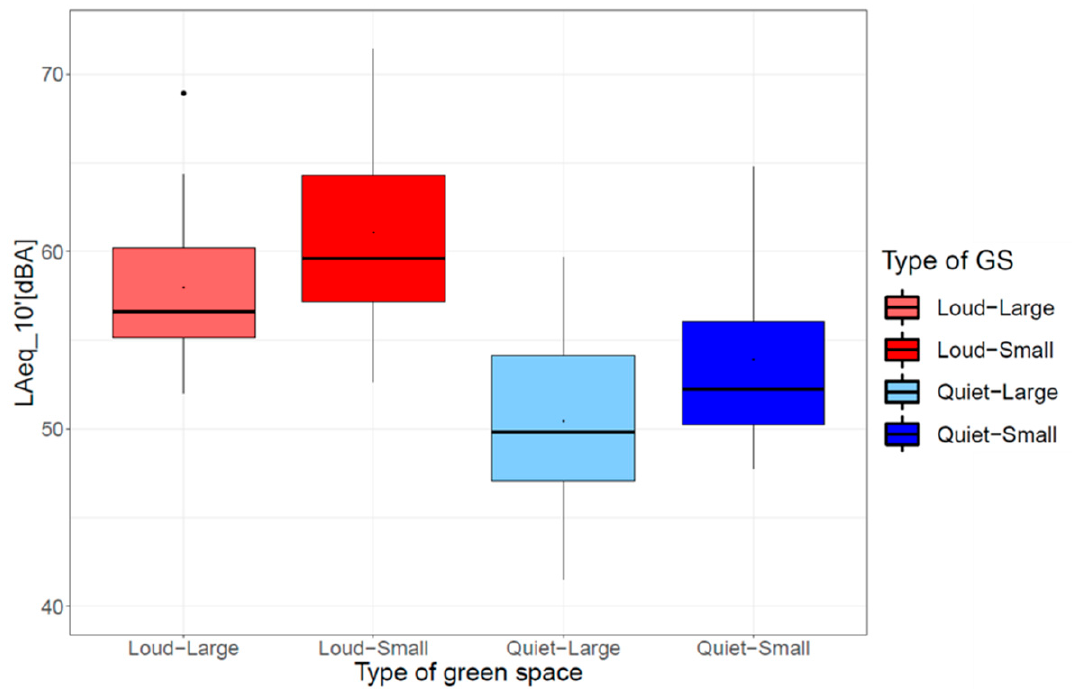
Figure 5. Boxplots with mean (point in boxes), median (horizontal line in boxes), the first and third quantiles (25% and 75%, lower and upper boundaries of boxes), whiskers comprising the data within 1.5 times the interquartile range and outliers outside the whiskers of the short-term A-weighted equivalent continuous sound pressure level, L Aeq_10 (cid:48) in GSs classified by size and noise exposure. Figure 6 shows the psychoacoustic loudness N5 _ and short-term L of the GSs 10 (cid:48) Aeq_10 (cid:48) assigned to five of the seven study groups ( HNA and LNA do not have access to GSs and thus have nothing to measure). Both indicators discriminate the GSs assigned to the